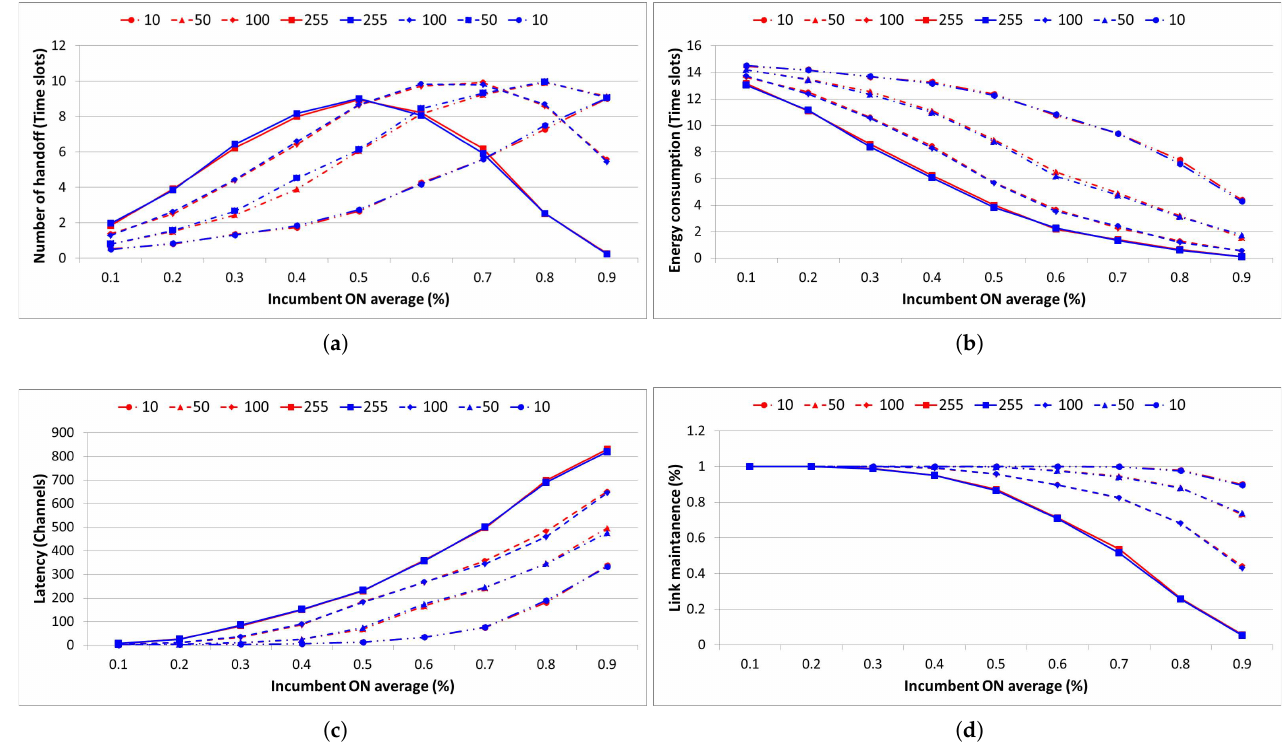
Figure 20. Comparative analysis of spectrum resource management performance (( a ) spectrum handoff, ( b ) energy consumption, ( c ) latency, ( d ) link maintenance) depending on whether or not case-based reasoning is